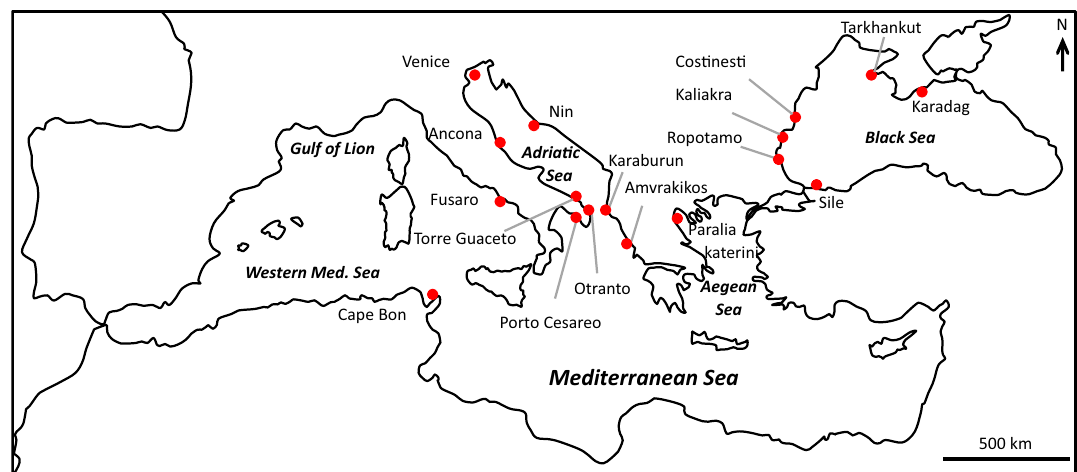
Figure 1. Map of the 17 localities sampled for Tritia neritea in the Mediterranean Sea.